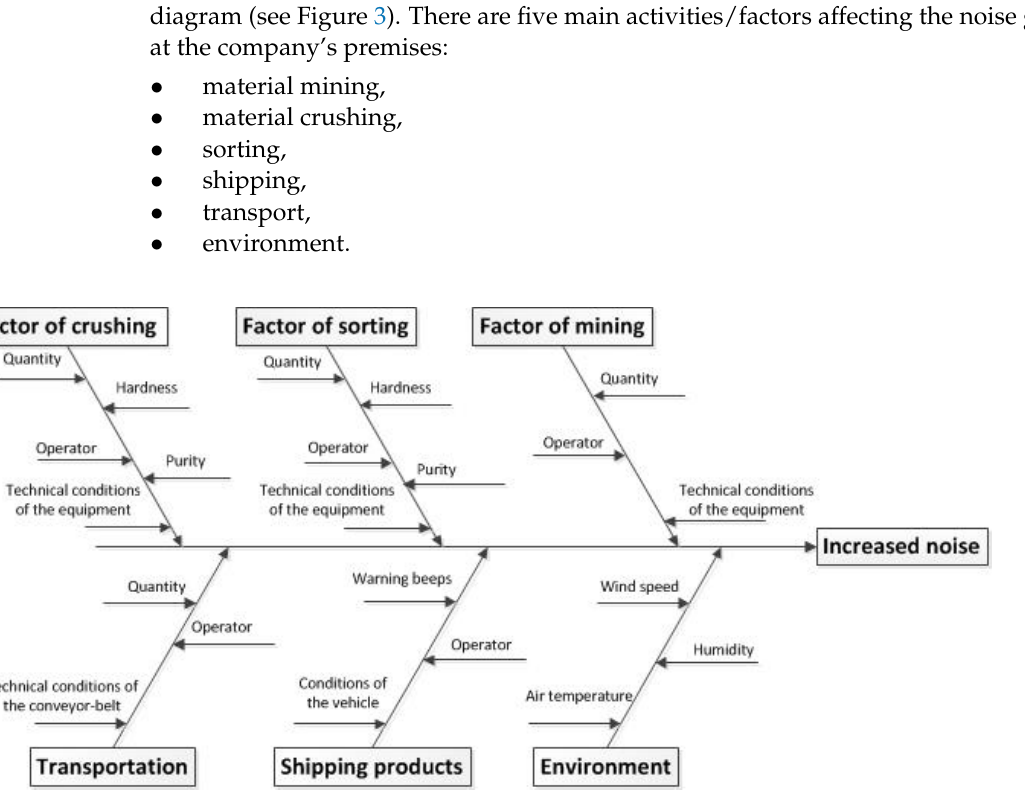
Figure 3. Cause-and-effect diagram.